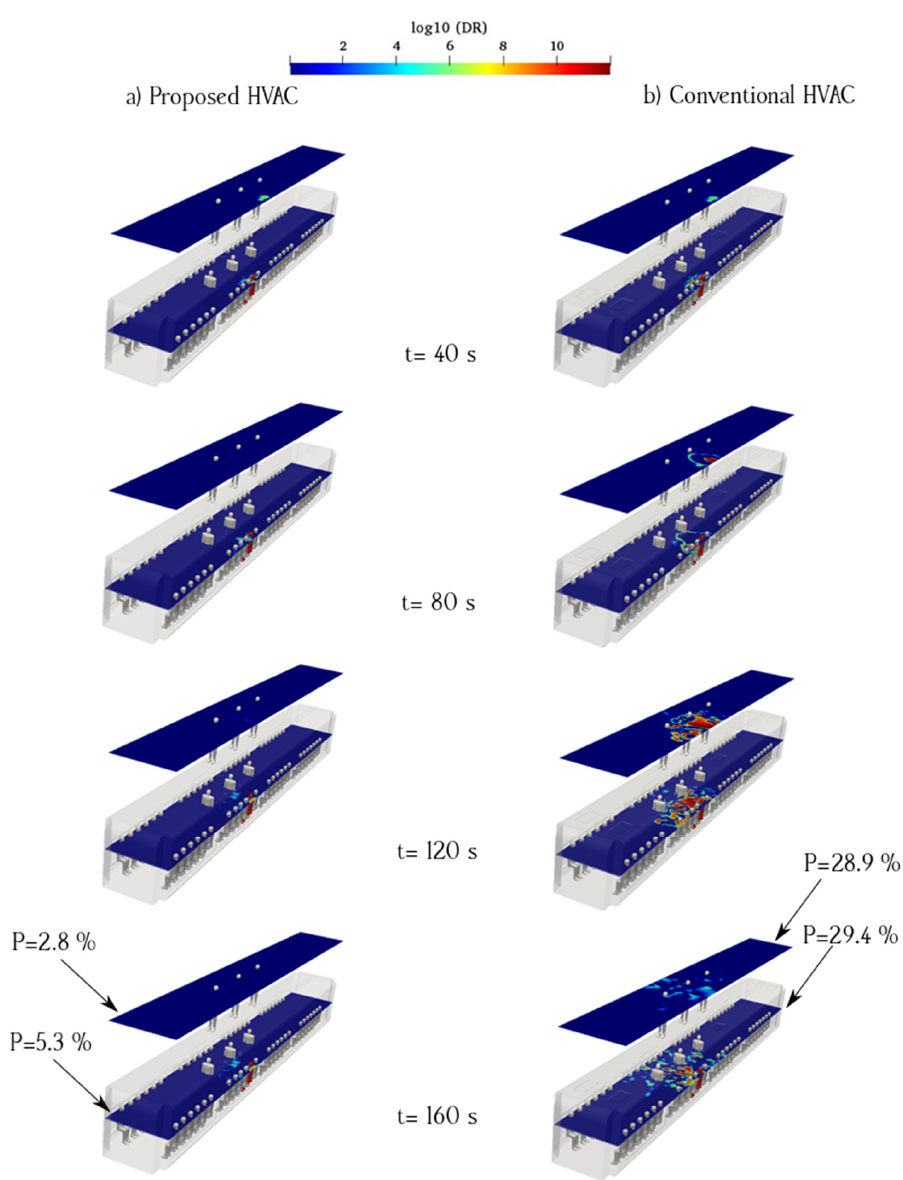
Figure 12. Time evolution of the counters of log 10 (DR) when the infected individual is sitting near the supply air ducts of the proposed ( a ) and conventional ( b ) HVAC systems (Case 4).